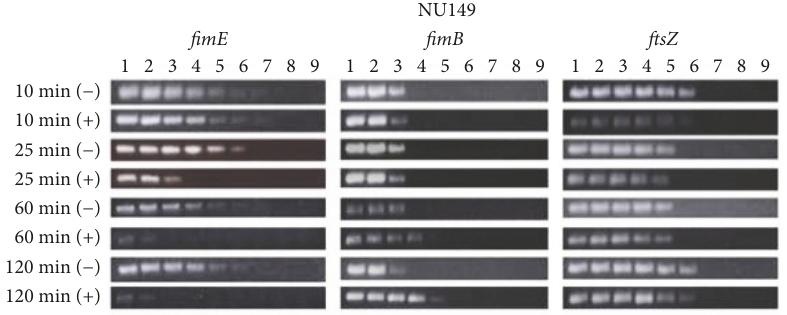
Figure1:QuantitativedeterminationofmRNAregulationbyLD-RT-PCRanalysisofcDNAsofstrainNU149cellsmixedwithplainSepharose beads ( − ) or mannose-coated Sepharose beads (+) for 10, 25, 60, or 120min. The FimB1/FimB2, FimE1/FimE2, and EcFtsZ1/EcFtsZ2 primer pairswereusedtoamplifyseriallytwofolddilutedcDNAsandtargeted fimB (379 bpproduct), fimE (392 bpproduct),and ftsZ (302bpproduct) transcripts, respectively. All PCR products were electrophoresed on 1.5% agarose gels. The following dilutions of cDNAs were used: undiluted (lane 1), 1/2 (lane 2), 1/4 (lane 3), 1/8 (lane 4), 1/16 (lane 5), 1/32 (lane 6), 1/64 (lane 7), 1/128 (lane 8), and 1/256 (lane 9). The data represent at least three separate runs.